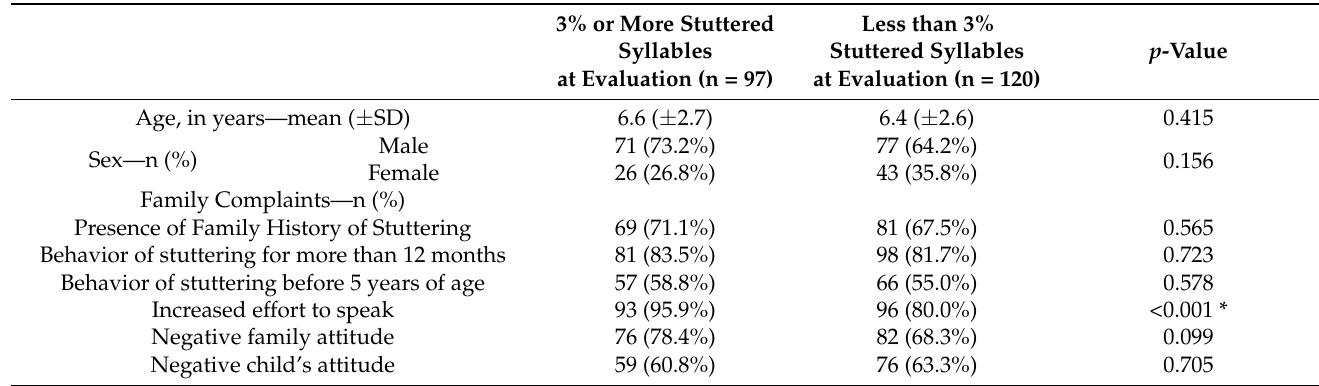
Table 2. Univariate comparison of children who did and did not present stuttering, within the group of children with stuttering behaviors (N = 217).